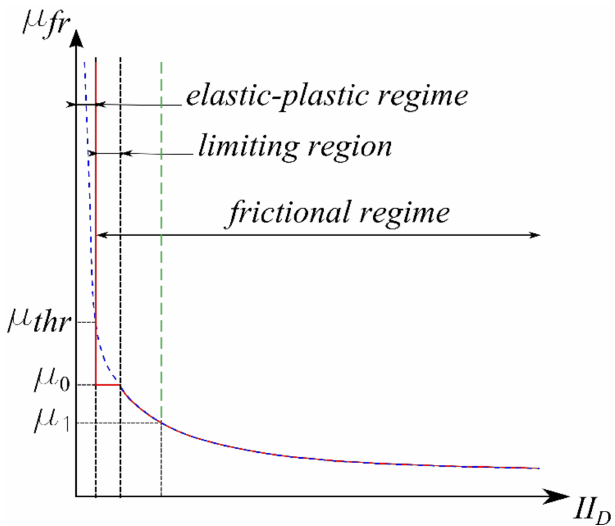
Figure 1. Apparent viscosity versus second invariant of the rate of deformation tensor: the blue dashed line refers to typical pseudoplastic behavior, while the red line refers to the non-Newtonian rheological behavior of the reference mixture model, as modified by the limiting